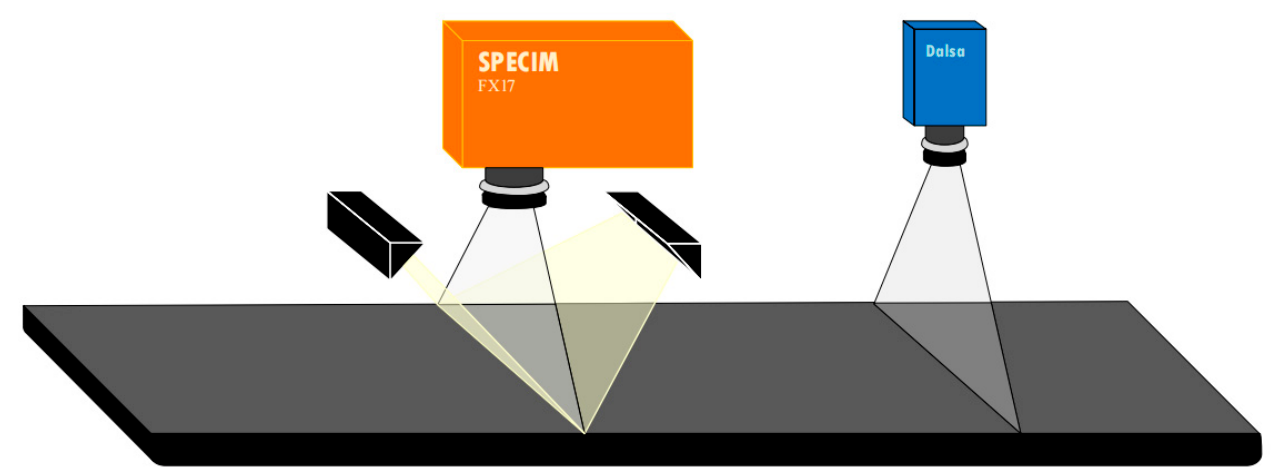
Figure 1. Dual camera platform mode of image acquisition.